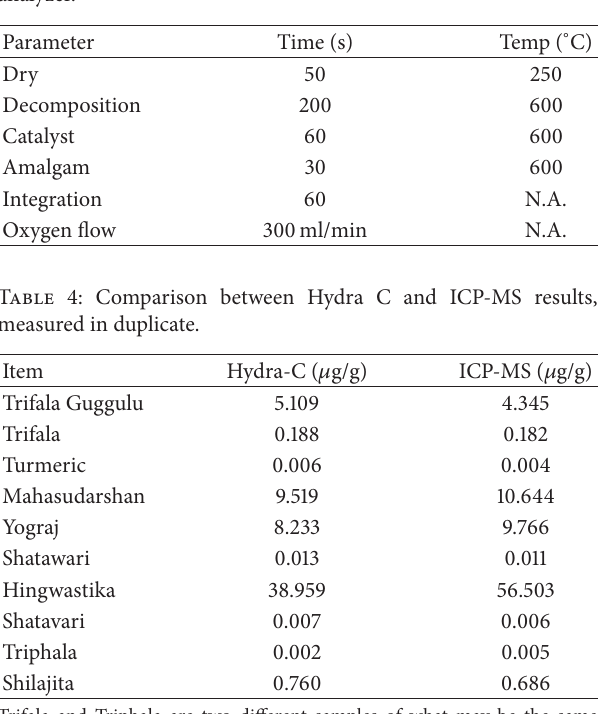
Table 3: Standard operating conditions for Hydra-C direct mercury analyzer.